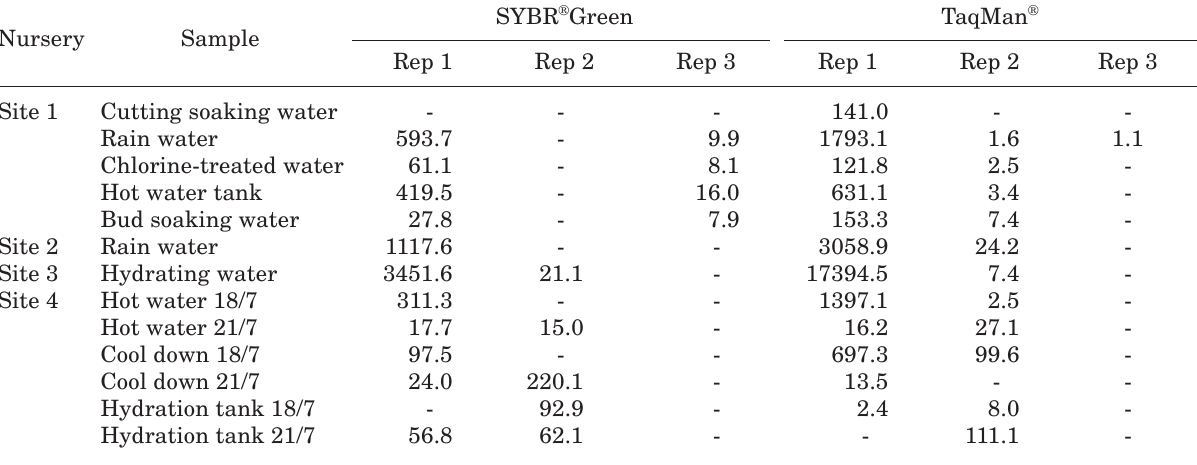
Table 6. Detection and quantification (spores ml -1 ) of P. chlamydospora in water samples collected from nurseries in July 2005 with quantitative realtime PCR using SYBR ® Green and TaqMan ®